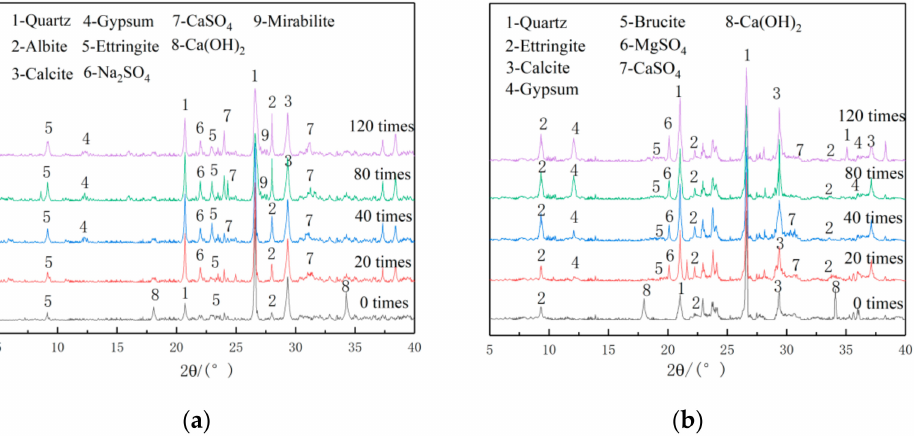
Figure 15. XRD spectrum of admixture concrete eroded by different erosion solutions. ( a ) 10% Na 2 SO 4 , ( b ) 10% MgSO 4